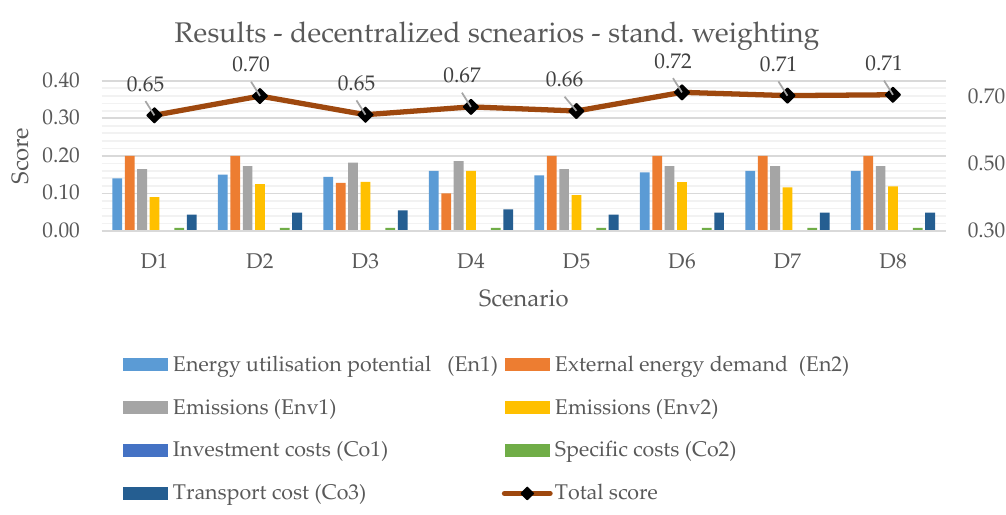
Figure 10. Overall results with the standard weighting for decentralized scenarios (1a,b). The score (left y-axis) of each evaluation criteria (En1, En2, Env1, Env2, Co1, Co2, and Co3) is shown for all scenarios (D1–D8). The total score (right y-axis) for each scenario is shown by line above the evaluation criteria bars.